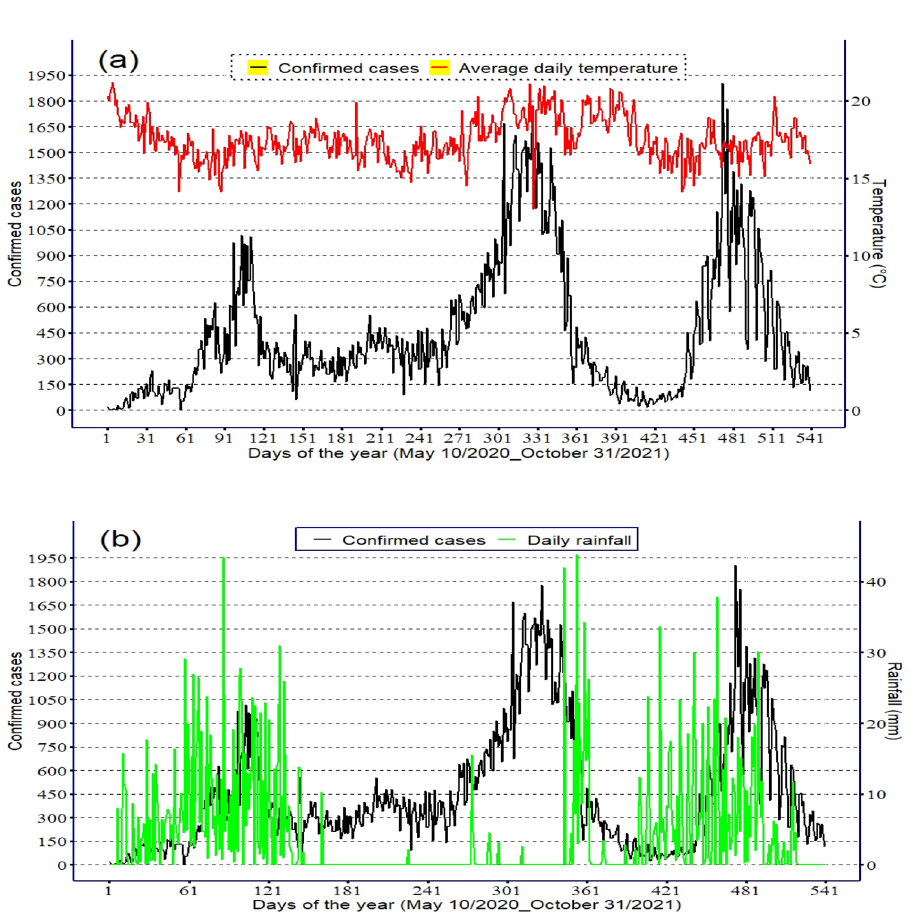
Figure 4. Daily variation of sunshine duration and ( a ) Average daily temperature, ( b ) Rainfall, ( c ) Relative humidity, ( d ) Wind speed and ( e ) Sunshine duration from 10 May 2020 to 31 October 2021 in Addis